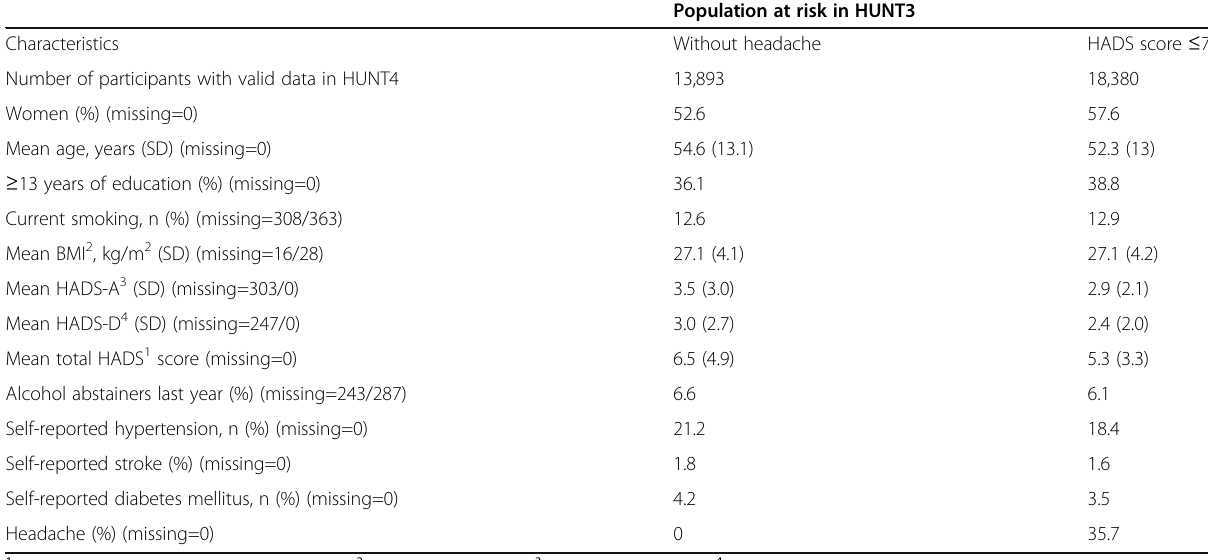
Table 1 Baseline characteristics of population at risk in HUNT3 with valid data in HUNT4 defined as respectively without headache and with anxiety and depression HADS 1 score of ≤